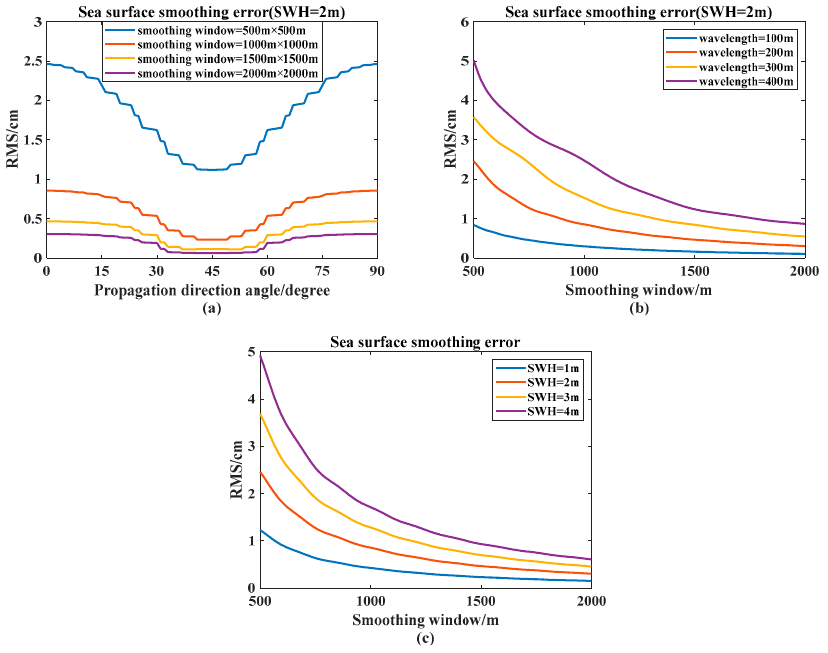
Figure 11. Influence of propagation direction, wavelength and SWH on smoothing error (in cm). The pixel size is 5 m × 5 m. The smoothing window is ( a ) square window. The incident angle in ( b ) and ( c ) is set to 0°.